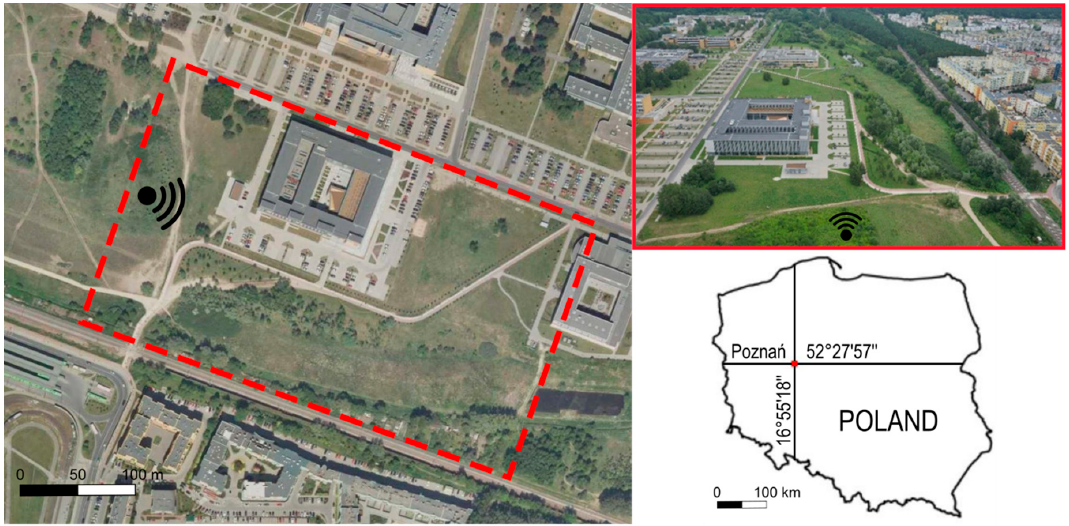
Figure 1. Location of the studied area (background layer orthophotomap from national geoportal www.geoportal.gov.pl).